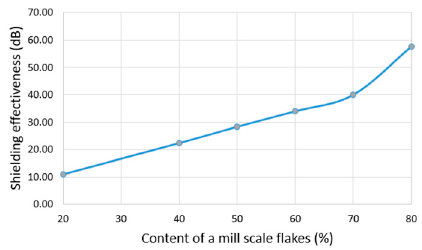
Figure 21. SE dependence of content of iron scale flakes. Frequency—23 GHz.